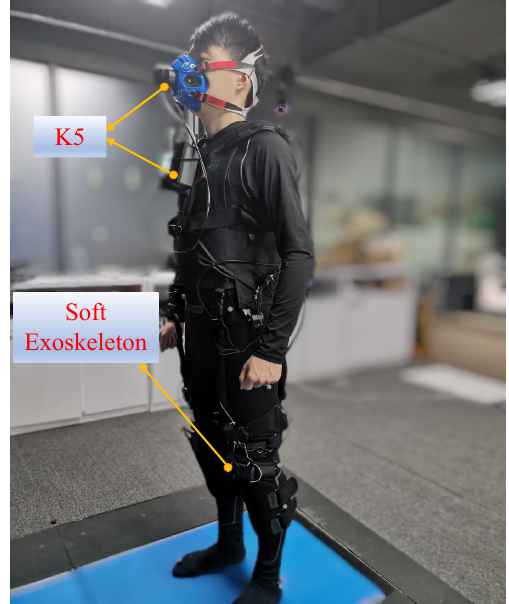
Figure 11. The subjects wore exoskeletons and walked on five different terrains. The Bowden cable driven by a motor assisted different forces in different terrain. The metabolic rate is measured through K5.